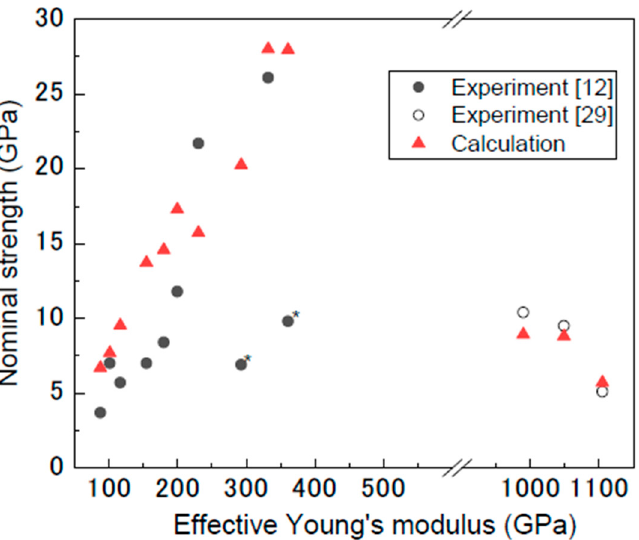
Figure 5. Nominal strength of CVD-grown and arc-discharge-grown MWCNTs obtained experimentally [12,29], and simulated nominal strengths obtained using Equation (7) and σ ef f = E eff /10 plotted as a function of the experimentally obtained Young’s modulus.